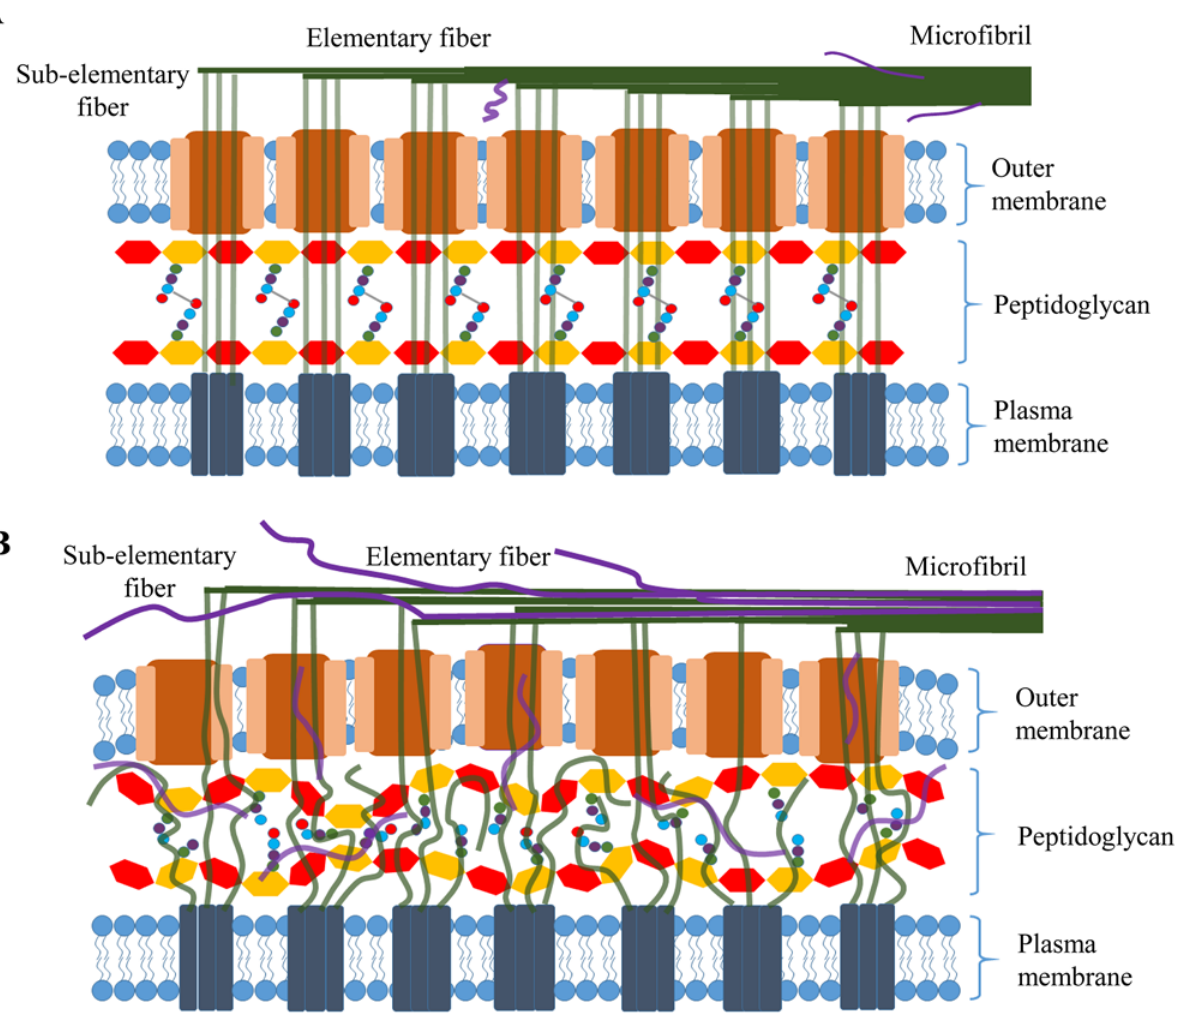
Fig 5. Model for the role of the peptidoglycan framework in cellulose synthesis. (A) The peptidoglycan framework providing guidance of glucan chains (green line) produced by each cellulose synthase complex located in the inner membrane through the periplasm to a pore, located in the outer membrane and in registry, to form a sub-elementary fiber for extrusion. Several sub-elementary fibers produced from more than one extrusion site aggregate to form a 3.5 nm elementary fibril, and adjacent elementary fibrils co-crystallize to form a 6 – 7 nm microfibril. (B) Effects of disruption of the peptidoglycan framework on assembly of glucan chains. The glucan chains (green line), synthesized in the inner membrane, may not be in perfect registry with the pore, and lack of guidance may result in some glucan chains not participating in the assembly of a sub-elemental fibril. Thus, the number of glucan chains that reach a pore may be reduced, and the less tightly packed glucan chains in the periplasm may allow non-cellulosic polysaccharides (purple curve line) to be incorporated into the sub-elementary